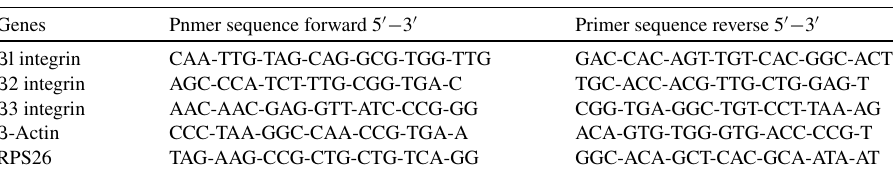
Primer sequences used for RT-PCR